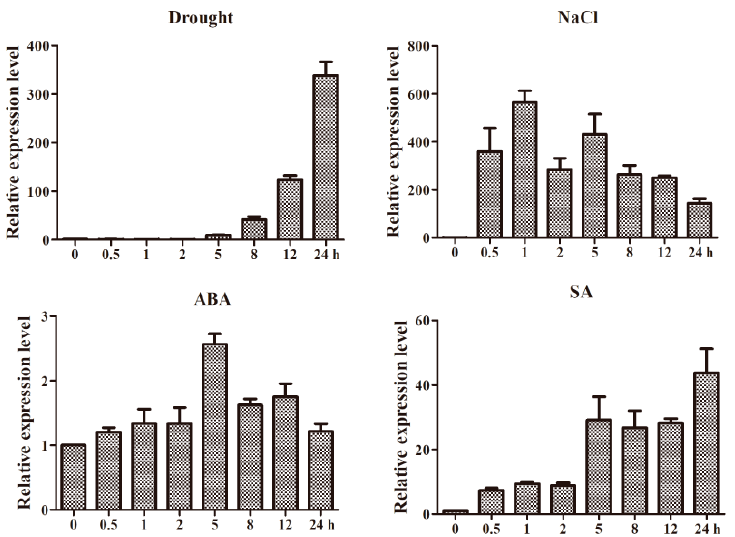
Figure 5. Expression patterns of GmWRKY12 under drought, NaCl, exogenous ABA and SA. The ordinates are the relative expression level (fold) of GmWRKY12 compared to non-stressed control. The horizontal ordinate is treatment time for 0, 0.5, 1, 2, 5, 8, 12 and 24 h. The expression level of GmActin as a loading control. All experiments were repeated three times. Error bars represent standard deviations (SDs). All data represent the means ± SDs of three independent biological replicates.